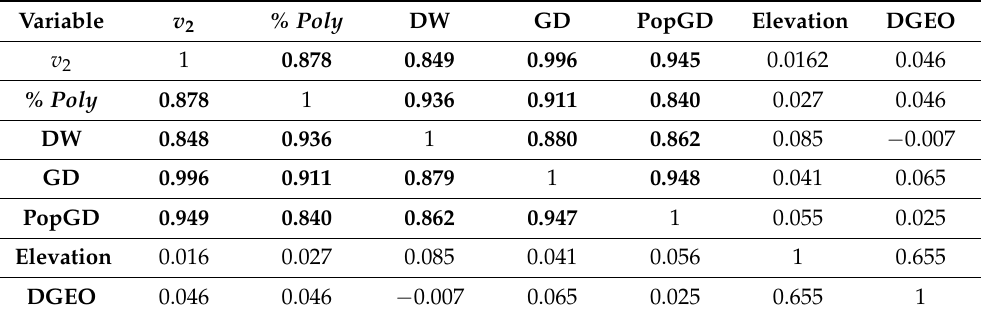
Table 2. Correlations between genetic and geographical variants of Pinus arizonica and the different peripheral and central populations of this species.